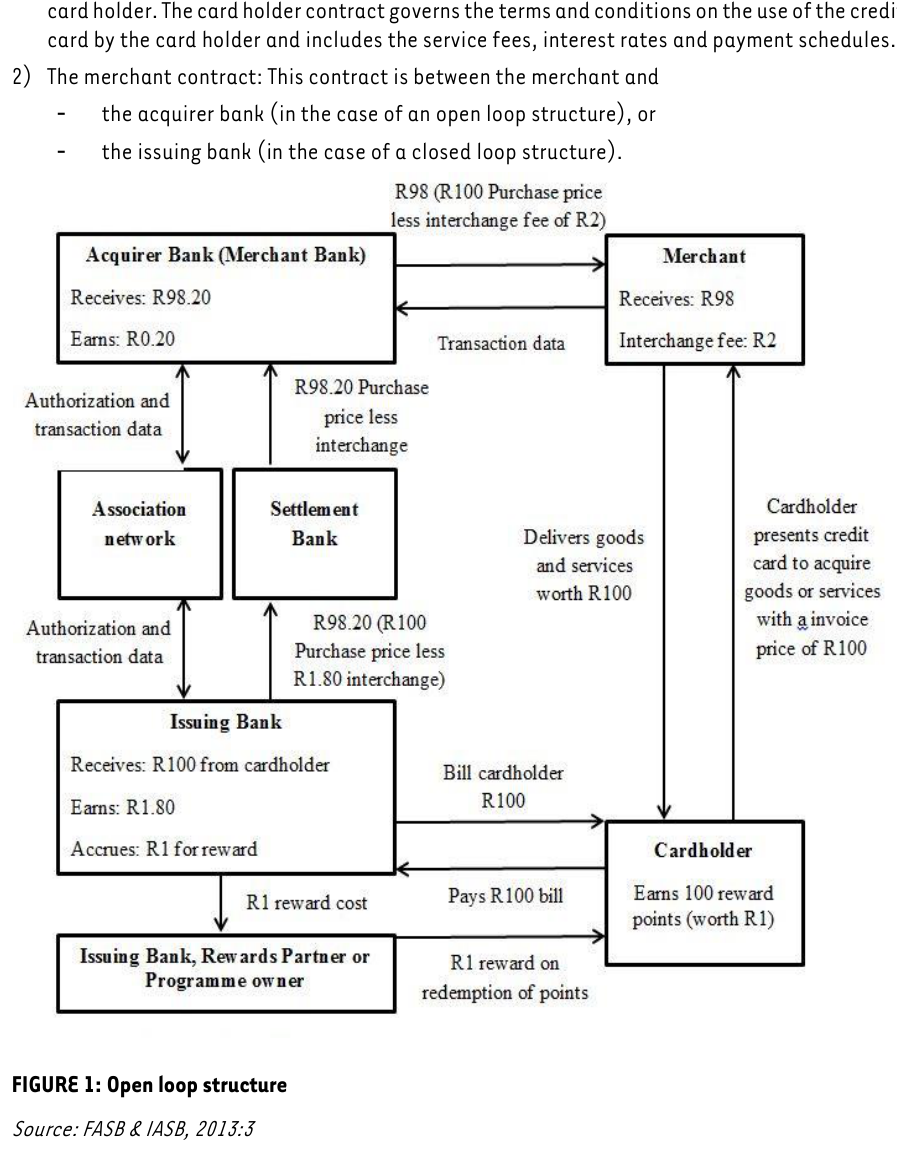
FIGURE 1: Open loop